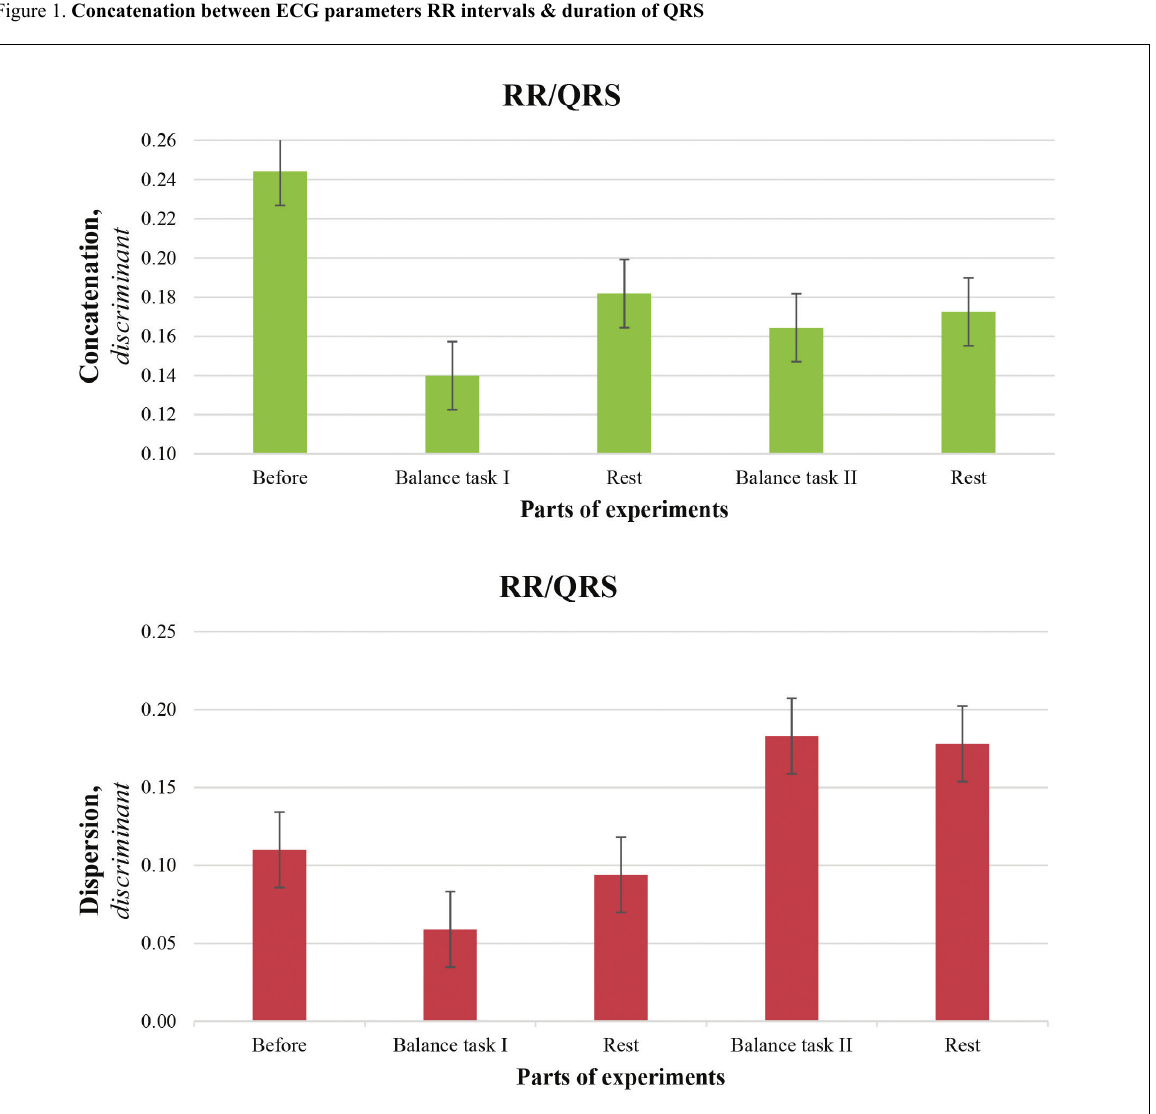
Figure 1. Concatenation between ECG parameters RR intervals & duration of